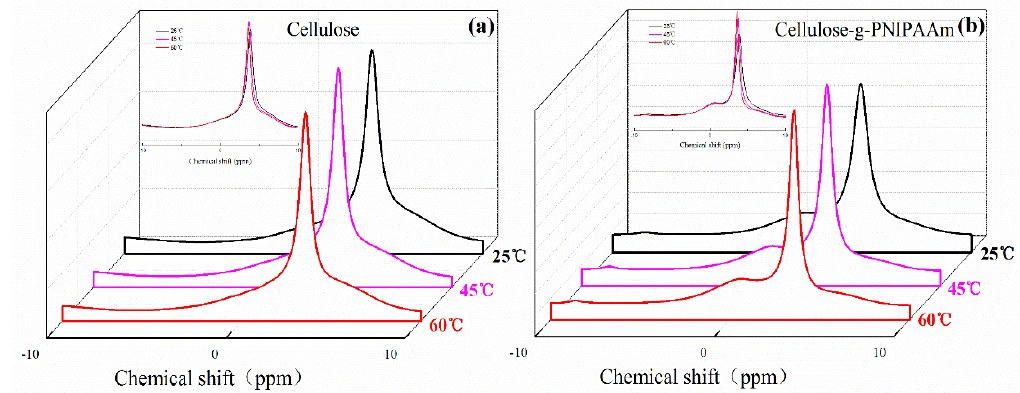
Figure 8. The in situ variable-temperature 1 H solid-state Nuclear Magnetic Resonance spectra of cellulose ( a ) and cellulose- g -PNIPAAm ( b ) in different temperature conditions of 25 °C, 45 °C and 60 °C.